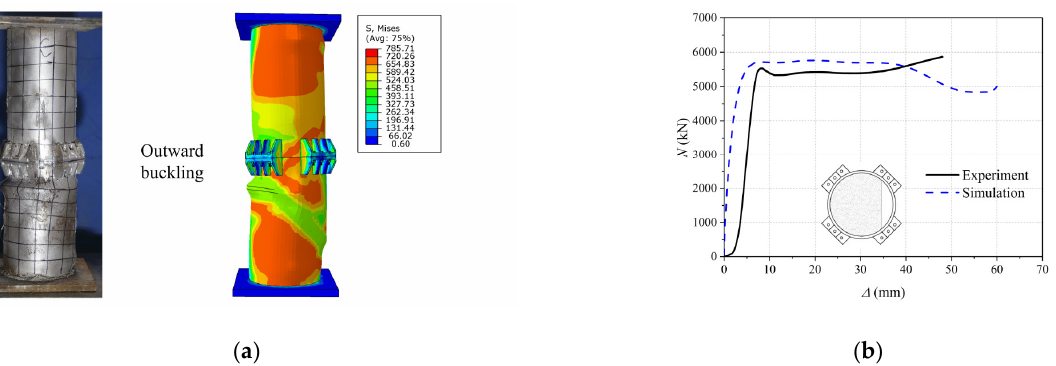
Figure 22. Comparison between experiment and simulation of BWCFST short column with χ of 2.3%: ( a ) Failure mode; ( b ) N - ∆ curve.